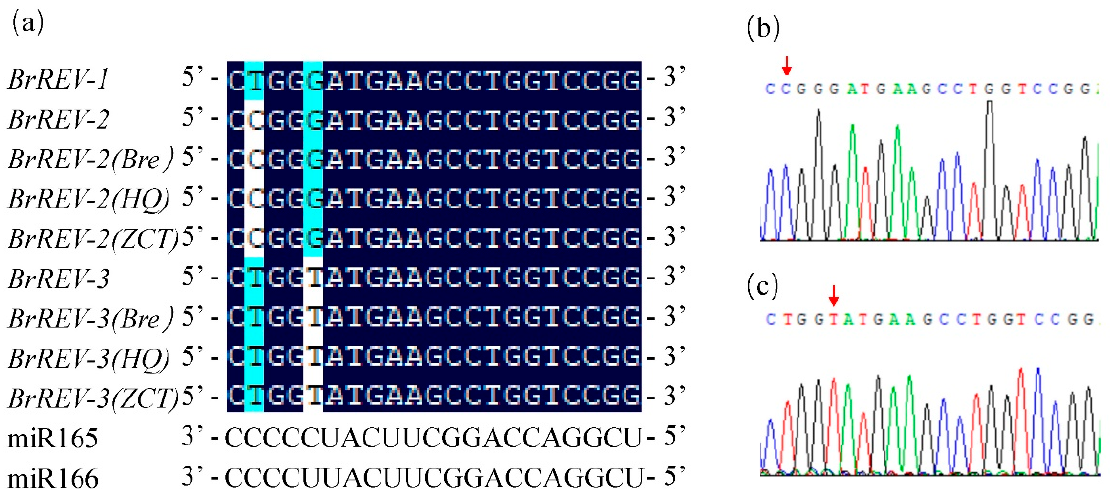
Figure 8. Validation of genetic variation in the BrREV genes targeted by miR165/166. ( a ) Alignment of the PCR sequencing